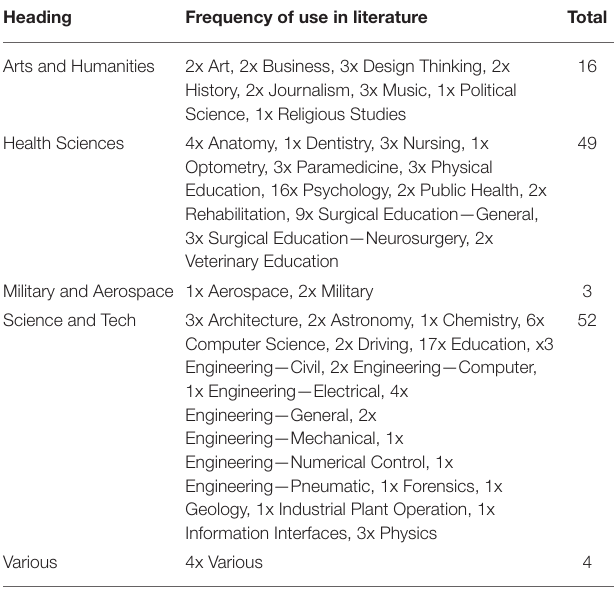
TABLE 4 | Frequency of immersive Virtual Reality literature across educational